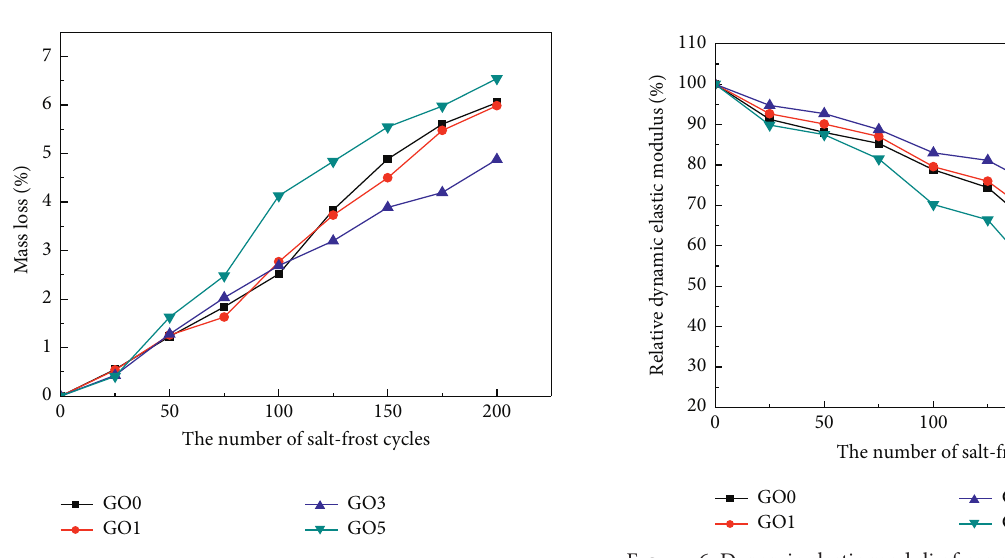
Figure 5: Mass loss rates of concrete under different salt-freezing